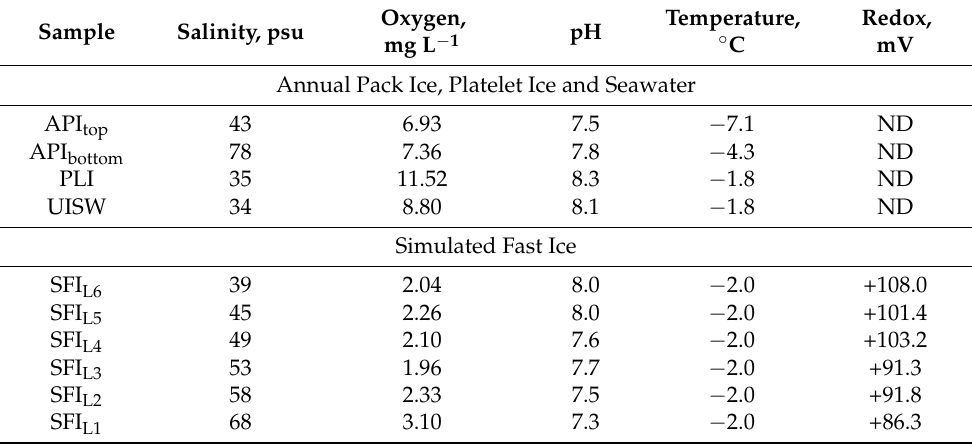
Table 1. Main physico–chemical parameters in natural matrices and simulated fast ice brine